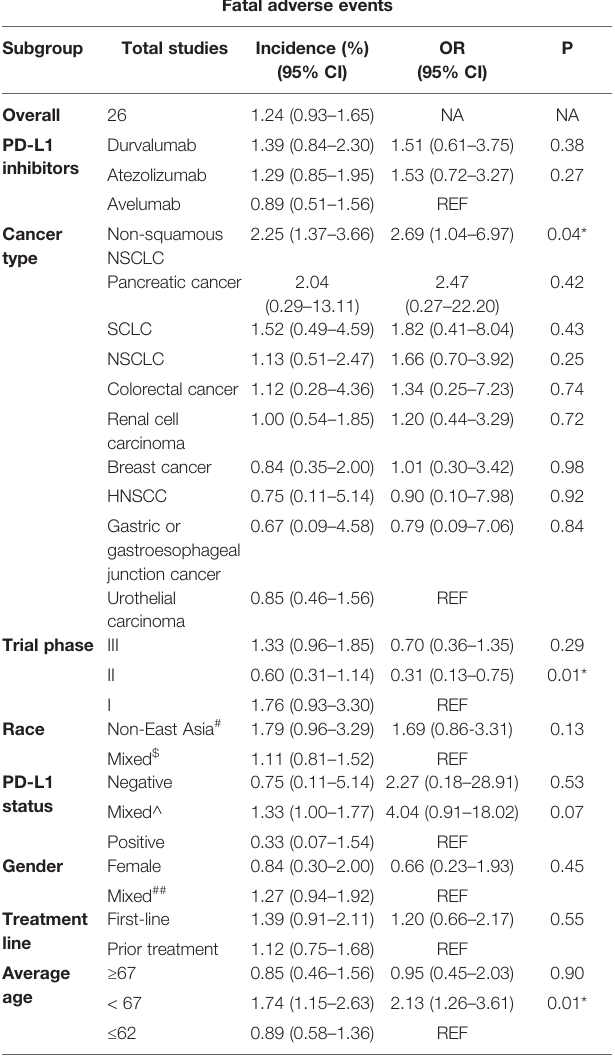
TABLE 2 | Results of subgroup analyses and univariate meta-regression of fatal adverse events associated with PD-L1 inhibitors.